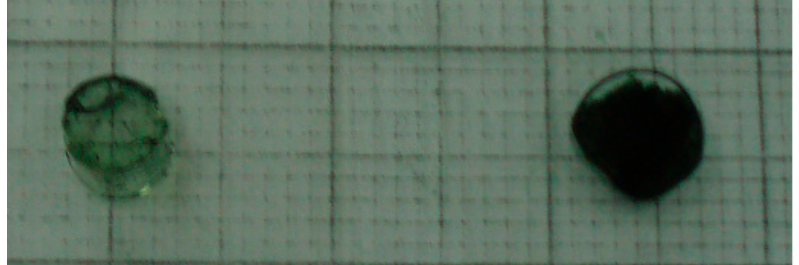
Figure 1. Photographs of poly( N -isopropylacrylamide) (PNIPAM) (with 2% 2-acrylamido-2-methyl-1-propanesulfonic acid (AMPS)) hydrogels after immersion in a dispersion of polyaniline (PANI) nanofibers. The nanoporous hydrogel ( left ) was made by polymerization at ambient temperature, where the macroporous hydrogel ( right ) was made by polymerization using cryogelation ( − 20 °C). Then, both were exposed to a dispersion (1% p/v) of PANI nanofibers in water. Both gels were exposed to 700 W of microwave radiation by 30 s.